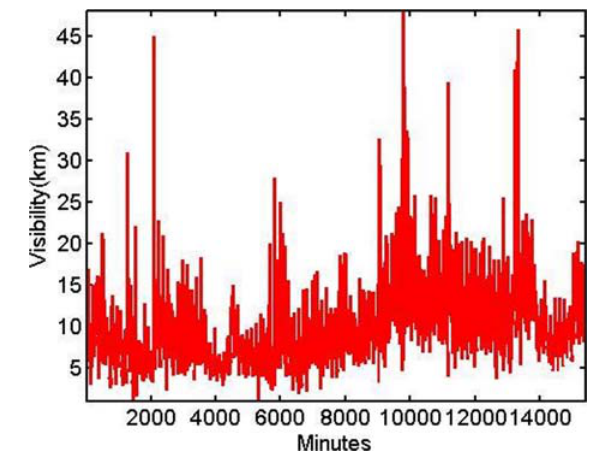
FIG. 1. TIME SERIES PLOT OF VISIBILITY FOR LAST FOUR MONTHS OF 2009